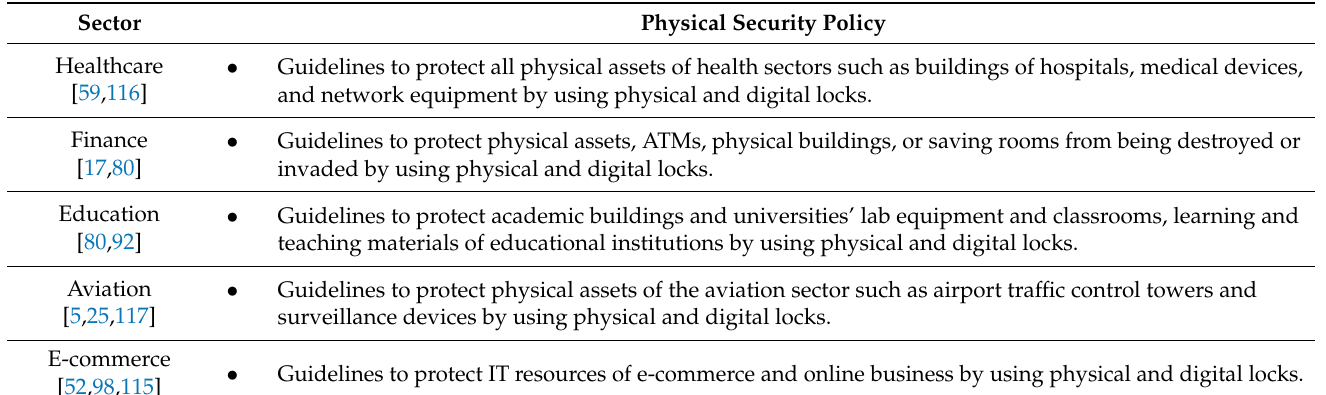
Table 6. Physical security policy among different